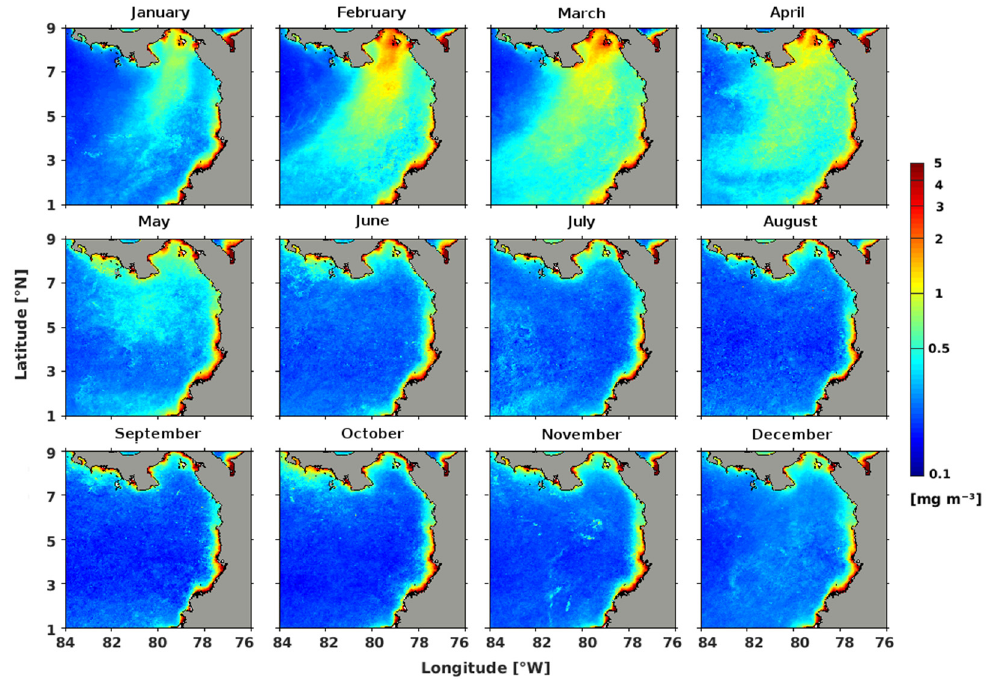
Figure 2. Monthly mean climatology of total chlorophyll-a (Chl-a) in the Panama Bight for the period of January 2002 to December 2016. The Chl-a is represented by a color scale.